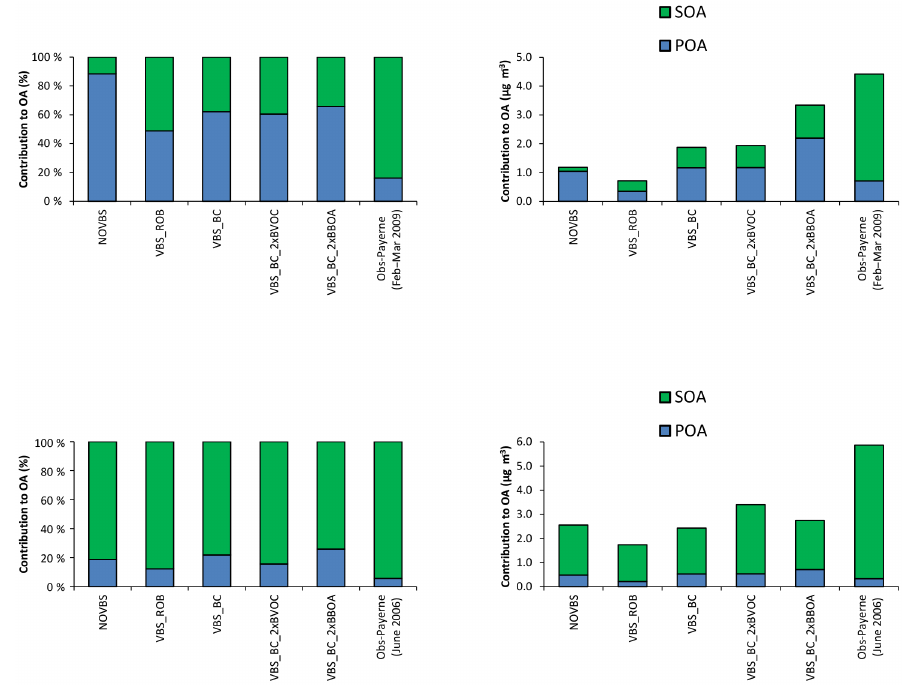
Figure 10. Relative (left) and absolute (right) contributions of predicted and measured POA and SOA fractions to the total OA mass at Payerne for February–March 2009 winter period (upper panel) and June 2006 (lower panel) and different model scenarios. NOVBS (tradi- tional nonvolatile POA), VBS_ROB (Robinson et al., 2007), VBS_BC (Tsimpidi et al., 2010; Shrivastava et al., 2011), VBS_BC_2xBVOC (increased biogenic emissions relative to VBS_BC), VBS_BC_2xBBOA (increased biomass burning emissions relative to VBS_BC), Obs- Payerne